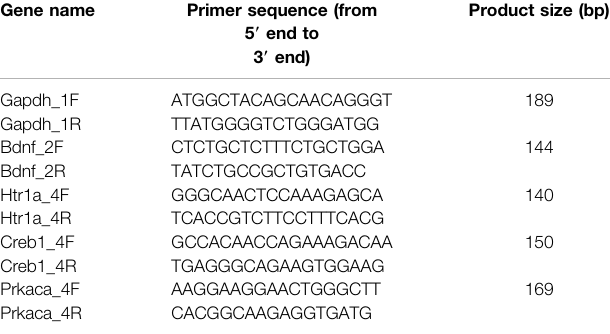
TABLE 2 | Primer sequences for rat target